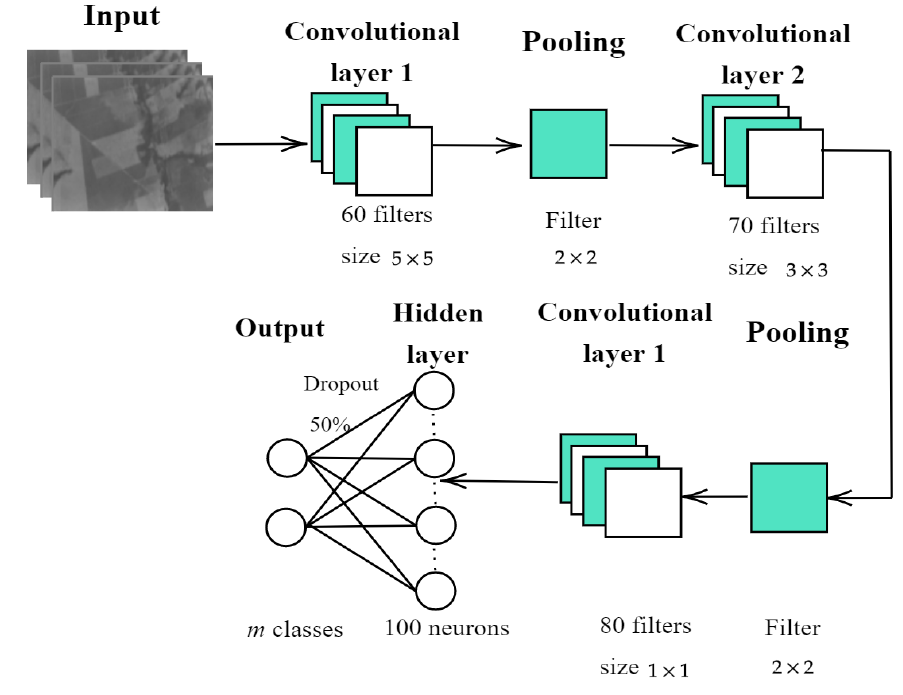
Figure 5. A schematic view of the proposed 2D-CNN